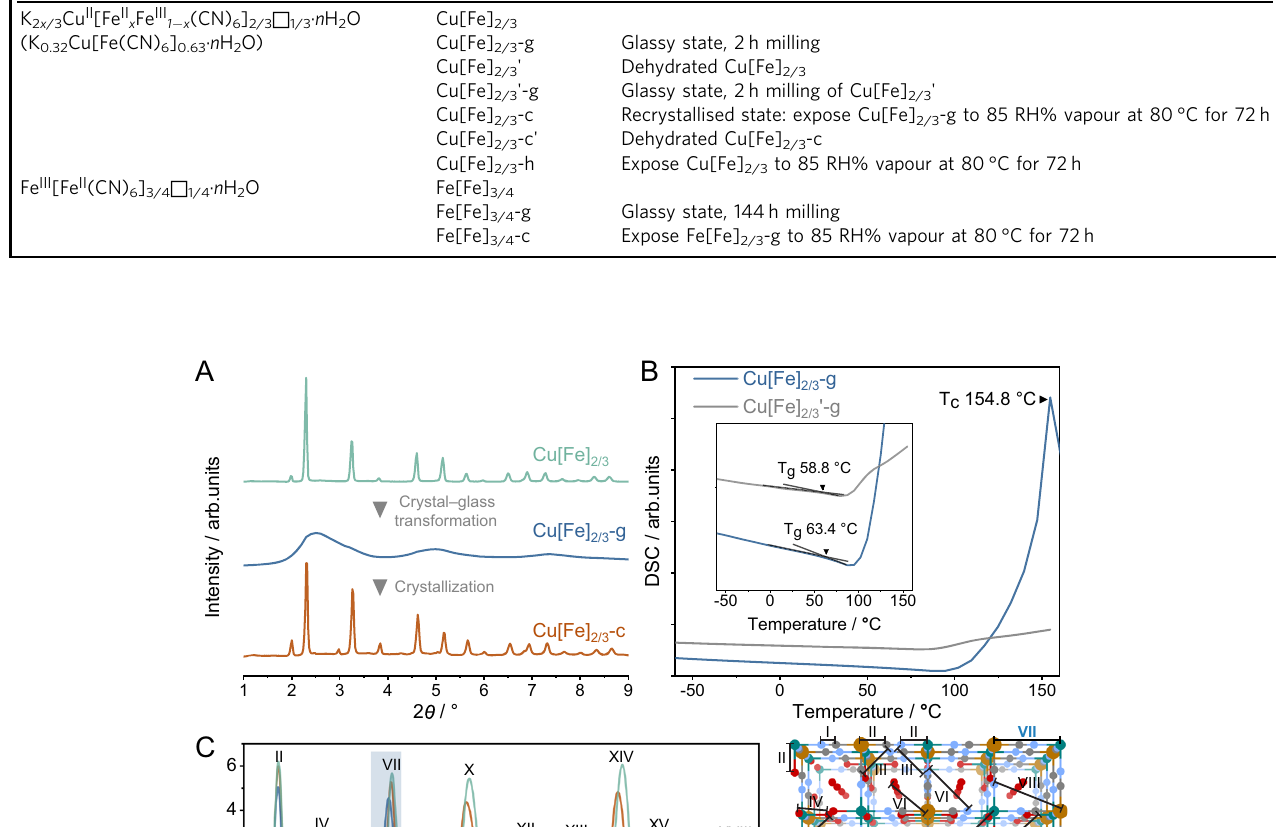
Table 1 Summary of crystalline and glass samples. Starting sample